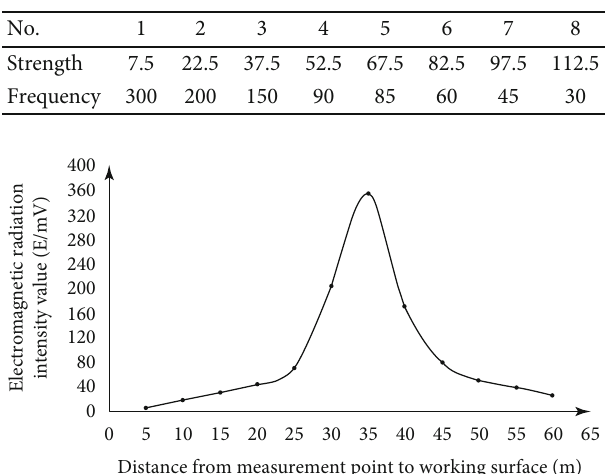
Table 7: Statistics of the frequency of electromagnetic radiation intensity monitoring.